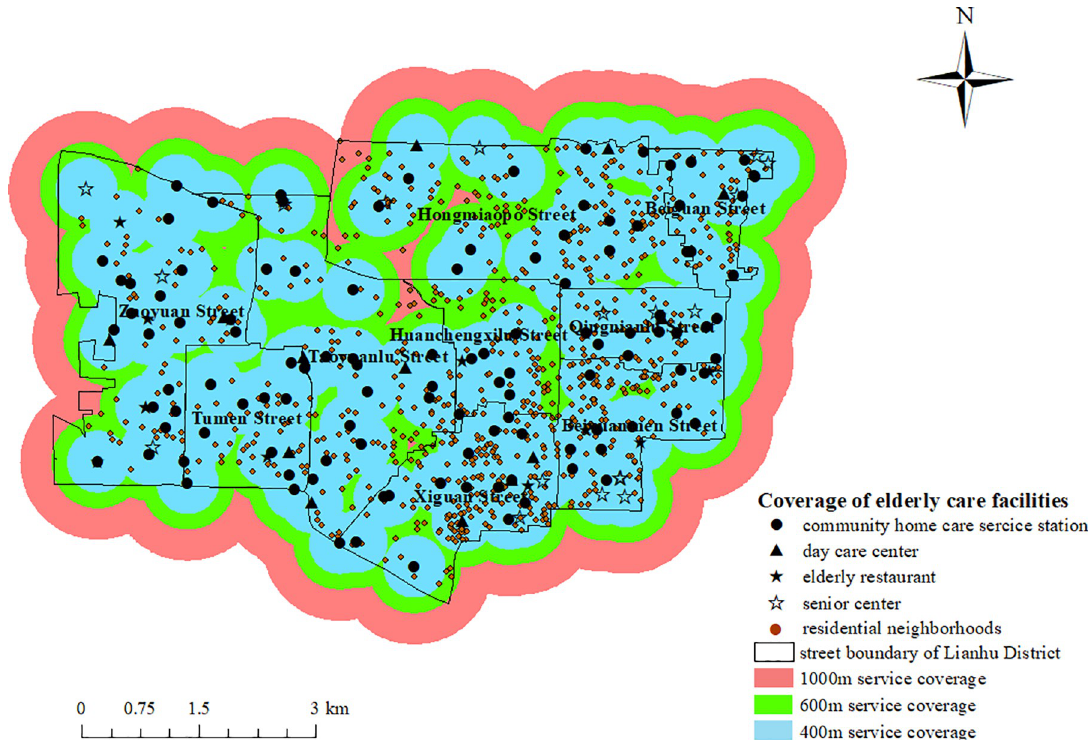
Fig 8. The coverage rate of community home care facilities from the perspective of the elderly with different mobility. (Self-drawn by the author).